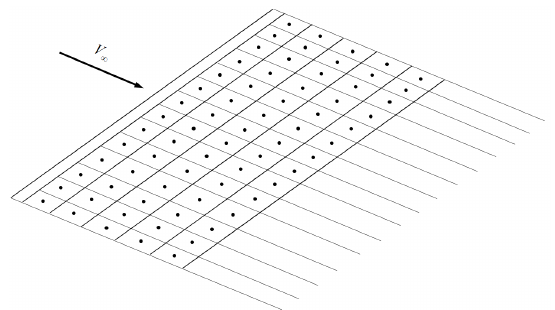
Figure 3. Vortex lattice system on a finite wing